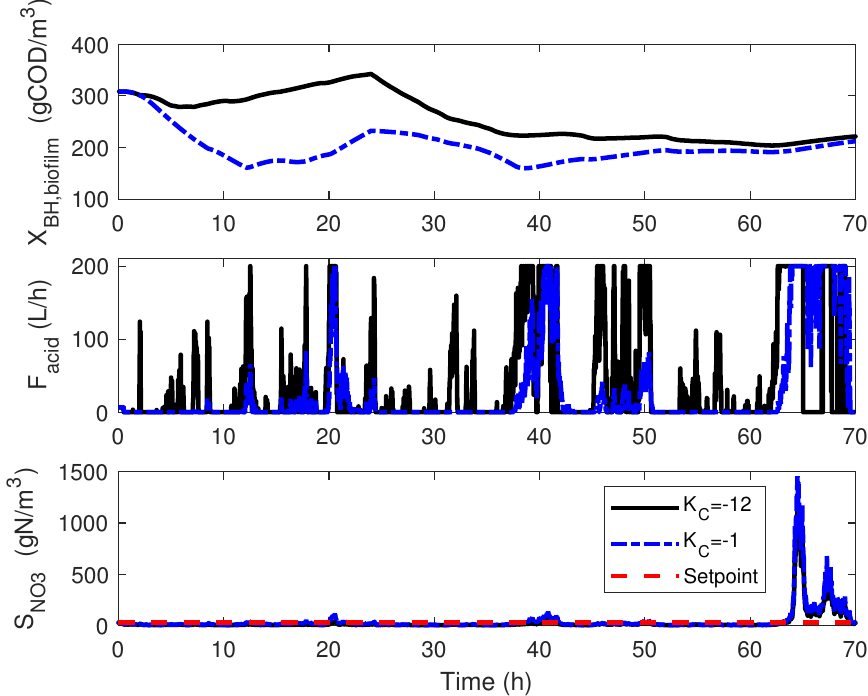
Figure 10. Nitrate concentration and acid flowrate evolutions for an increase in biomass decay rate from 2.6 10 2 to 7.8 10 − 2 h − 1 while using two PID controllers with different proportional gains × × ( K C )—Gaussian noise with zero mean and 10% relative standard deviation is added to the measured variable ( S NO 3 ).